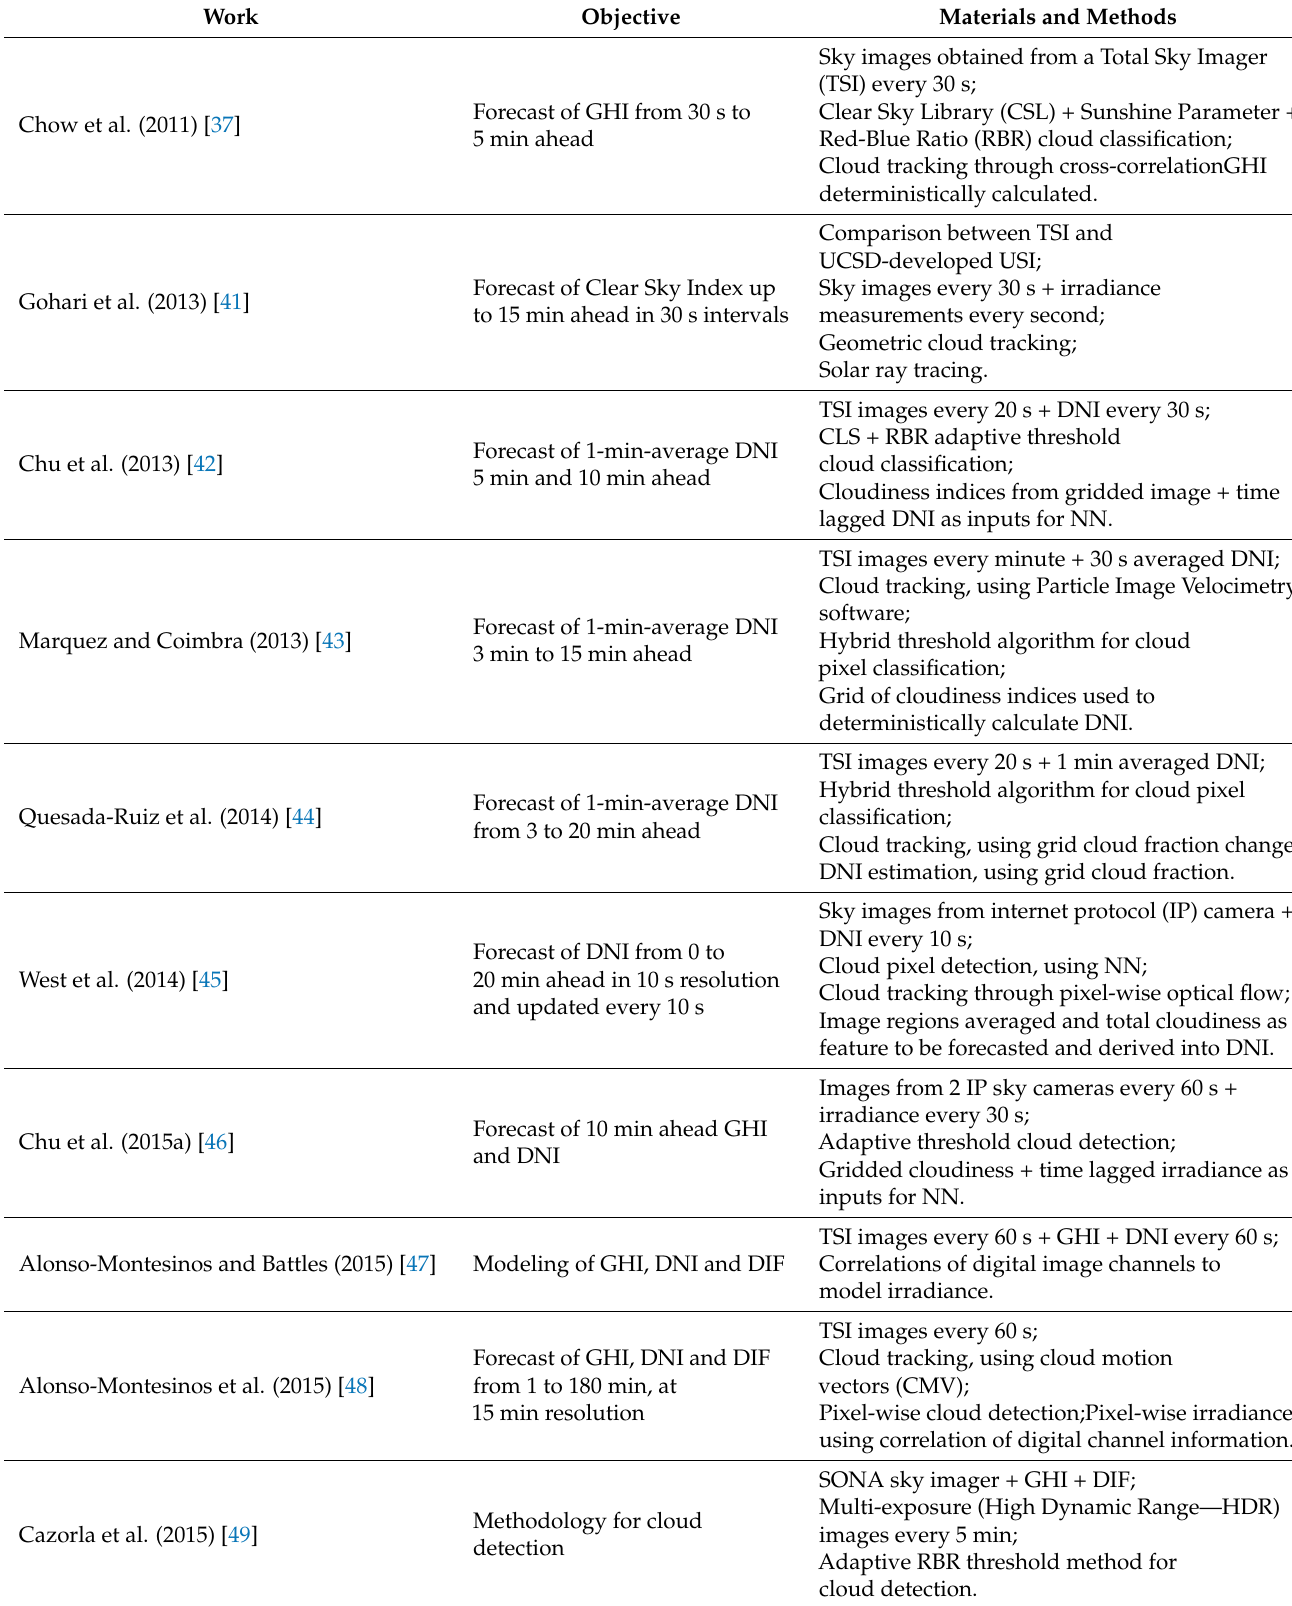
Table 2. Important works that shaped this